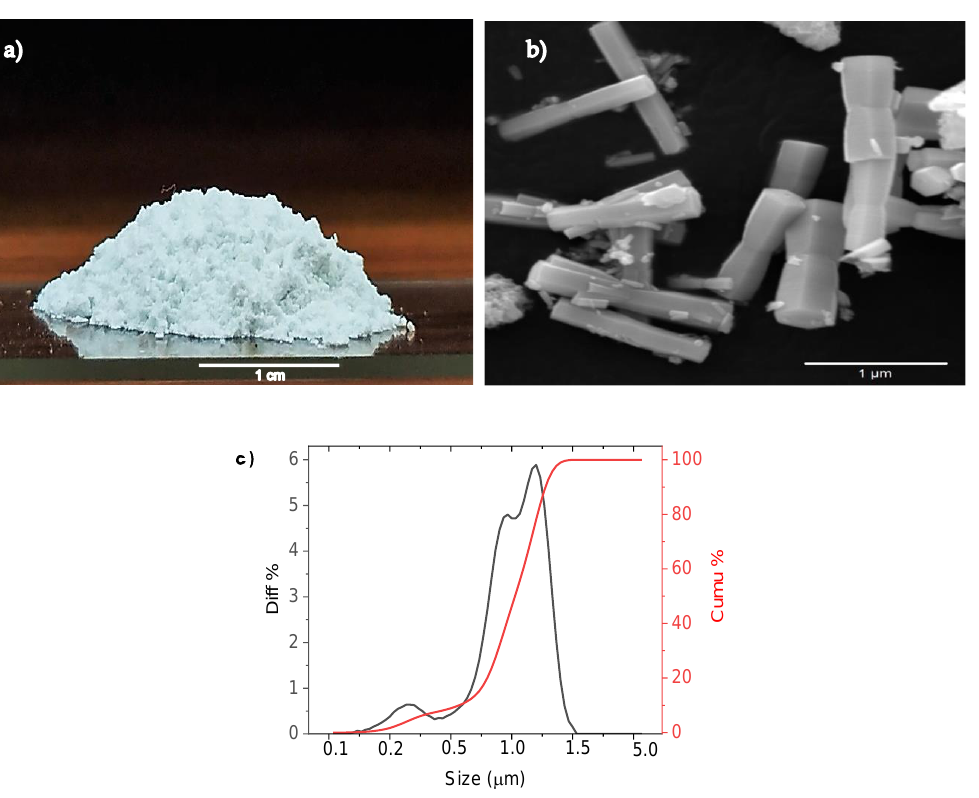
Figure 2. ( a ) Synthesis nanopowder of ZnO. ( b ) Scanning electron microscopic (SEM) micrograph of the prepared ZnO nanorods. ( c ) Differential volume PSD for synthesis ZnO powder.